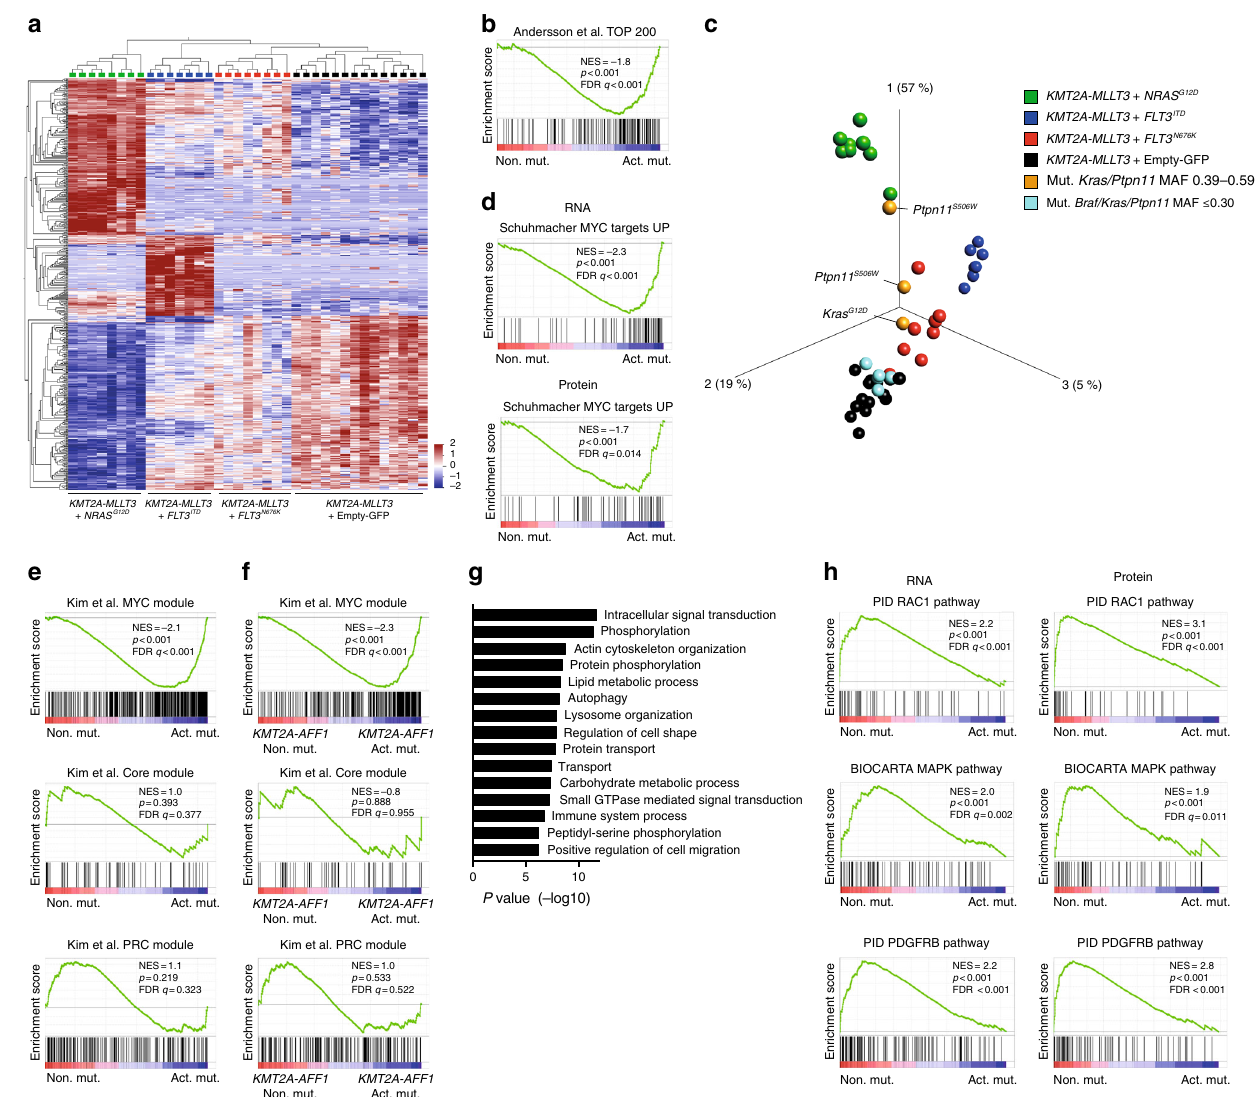
Fig. 4 Activating mutations enforce Myc and Myb modules. a Hierarchical clustering after multigroup comparison of mouse leukemias using 553 variables ( P = 2.9e − 8 , FDR = 6.6e − 7 . F -test) reveals that each activating mutation causes a distinct gene expression pro fi le. b GSEA revealed enrichment of a signature of the top 200 genes that discriminate infant KMT2A-AFF1 ALL patients harboring activating mutations (dominant or subclonal) to those lacking such mutations 4 for mouse leukemias carrying KMT2A-MLLT3 with FLT3 ITD , FLT3 N676K , or NRAS G12D (Act. mut.). c Principal component analysis (553 variables, P = 2.9e − 8 , FDR = 6.6e − 7 . F -test) of primary mouse leukemias. KMT2A-MLLT3 leukemias with de novo mutations in Braf , Kras or Ptpn11 were inserted into the same PCA (still based solely the leukemias de fi ned above), showing that leukemias with de novo mutations with a MAF of 0.39 – 0.59 now fall closely to leukemias co-expressing KMT2A-MLLT3 and FLT3 ITD , FLT3 N676K , or NRAS G12D . d GSEA revealed enrichment of a MYC signature in the presence of FLT3 ITD , FLT3 N676K , or NRAS G12D (Act. mut.) both at the RNA and protein level. e GSEA revealed enrichment of the MYC module, but not Core or polycomb (PRC) modules 38 , for mouse KMT2A-MLLT3 leukemias with FLT3 ITD , FLT3 N676K , or NRAS G12D (Act. mut.). f GSEA revealed enrichment of the MYC module, but not Core or PRC modules 38 , in infant KMT2A-AFF1 ALL patients with activating mutations (dominant or subclonal; Act. mut.) to those lacking such mutations (Non. mut.). g Gene ontology enrichment results of genes upregulated in leukemias KMT2A-MLLT3 + Empty-GFP as compared to KMT2A-MLLT3 leukemias with either FLT3 ITD , FLT3 N676K , or NRAS G12D (FDR ≤ 0.01). h GSEA on transcriptomic- and proteomic data showed enrichment of intracellular signaling pathways, such as RAC1, MAPK, and PDGFRB, in KMT2A-MLLT3 leukemias lacking an activating phosphatase catalytic domains, known hotspots in human disease MLLT3 cells containing Ptpn11 S506W (Fig. 3j and Supplementary (E69 and S502) (Supplementary Fig. 6g, h). SHP-2 positively Fig. 7b – f). Thus, Ptpn11 S506W is a cooperating mutation in KMT2A- R leukemogenesis. regulate RAS signaling 31 and mutations are seen in KMT2A- R acute leukemia of all ontogenies 4,7 . Mutations at E69 and S502 The availability of a paired secondary leukemia allowed us to are known to increase SHP-2 phosphatase activity 23,24 , suggesting study the evolution of the acquired mutations. The Braf V637E was that also the mouse mutations would have similar effect. Co- subclonal at leukemia onset (MAF 0.20) and increased in size in expression of Ptpn11 S506W and KMT2A-MLLT3 accelerated AML the secondary recipient (MAF 0.30) (Fig. 3c and Supplementary Data 2). Similarly, Kras G12D was subclonal (MAF 0.11) at onset compared to control mice (median latency 27 vs. 44 days, P = 0.0005. Mantel – Cox log-rank test) with a majority of KMT2A- leukemia manifestation and gained clonal dominance in the